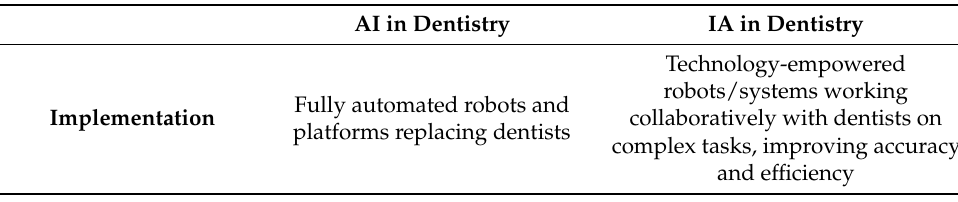
Table 1. AI vs. IA in